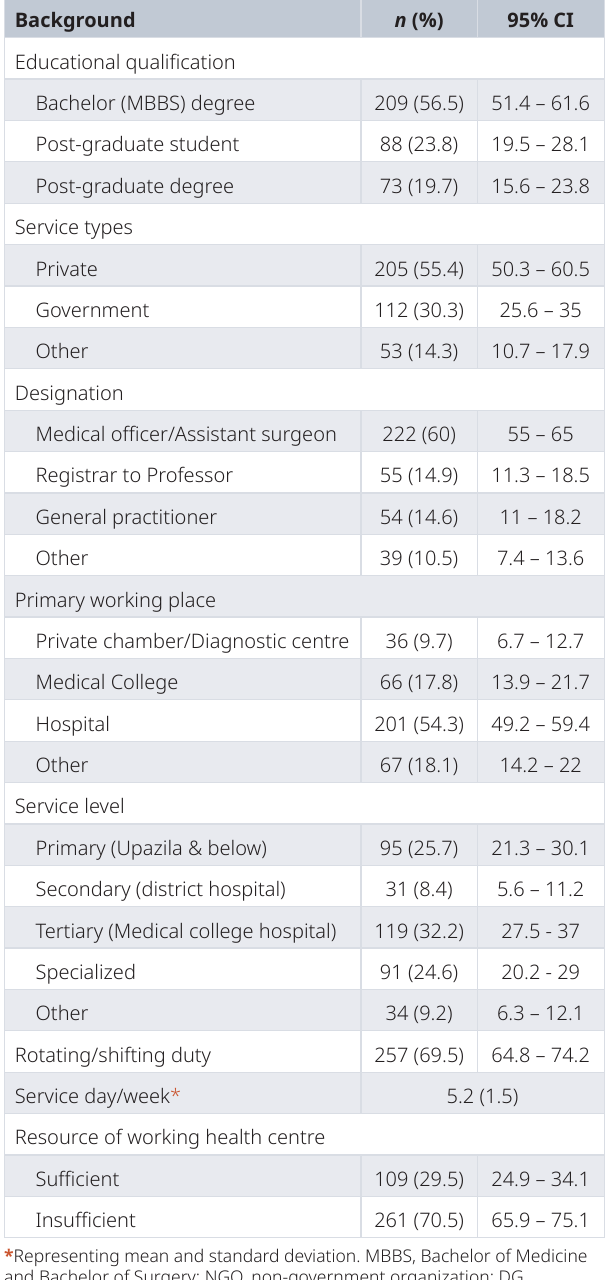
Table 2. Professional background of frontline doctors of Bangladesh (n=